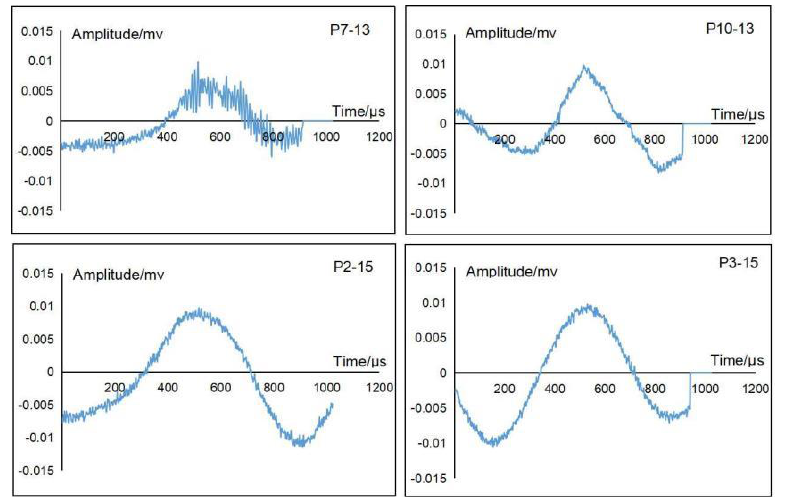
Figure 10. The original time domain AE waveforms of subpictures P7 – 13 and P10 – 13 in Figure 6, and those of subpictures P2 – 15 and P3 – 15 in Figure 8.